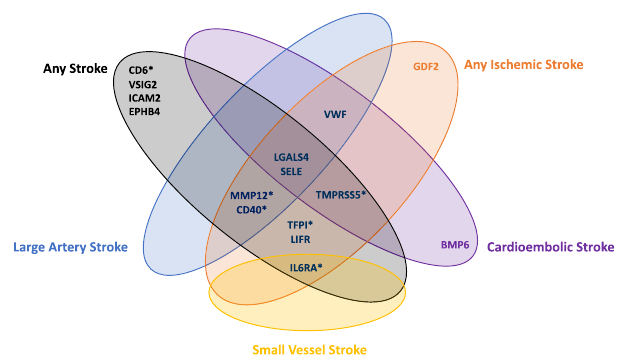
Fig. 2 | Venn diagram of identi fi ed potential causal proteins for stroke sub- types. *Indicatestheaccordingtoproteinisinstrumentedby cis -pQTLsonly.These six proteins are taken for further analyses.